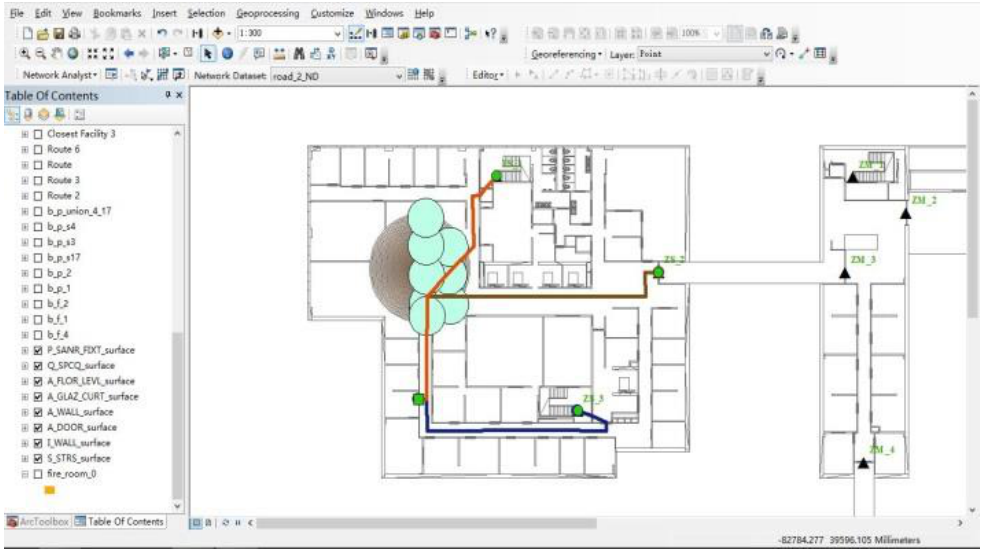
Figure 6. Example of optimal evacuation routes based on network